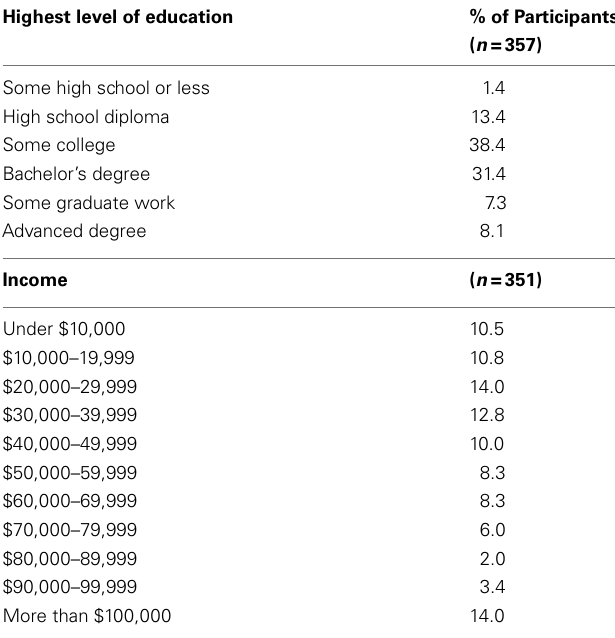
Table 1 | Distribution of participants’ education and income.